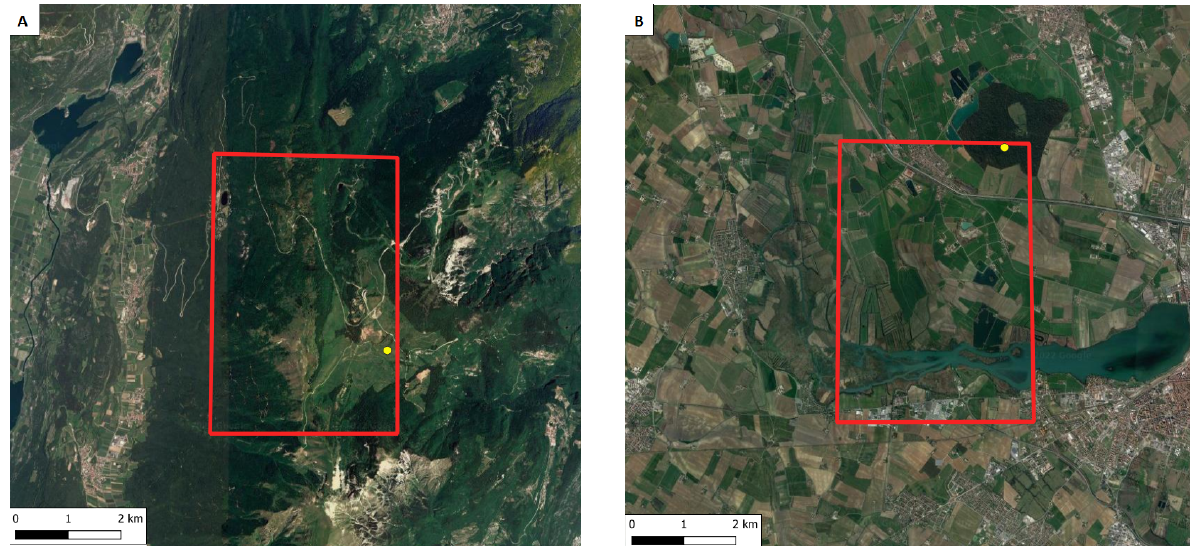
Figure 7. ( A ) shows the area of Monte Bondone and ( B ) shows the area of Bosco della Fontana; the yellow dot shows the position of the eddy covariance tower. The red rectangle shows the size of the CAMEL